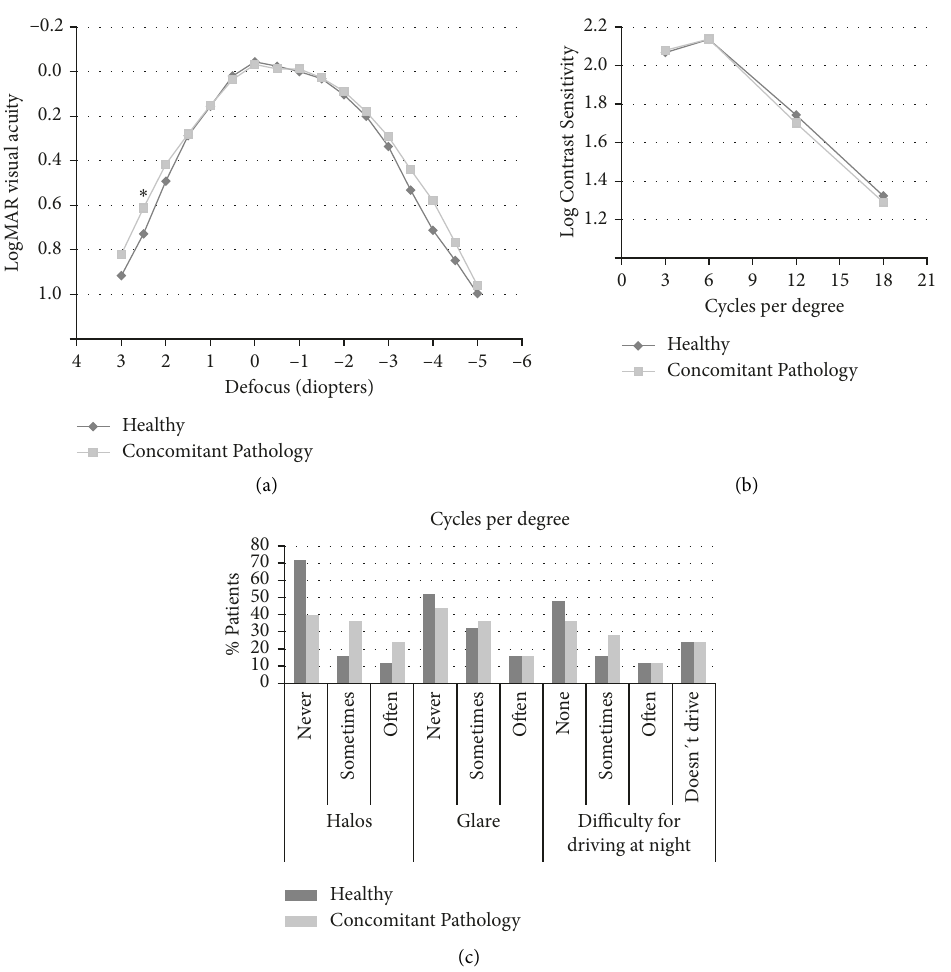
Figure 1: (a) Defocus curves for the study group (concomitant pathology) and the control group (healthy subjects). The asterisk ( the only defocus value, in which there was a statistically significant difference between groups (+2.50 diopters, p sensitivity. There were no statistically significant differences between groups. (c) Prevalence of halos, glare, and difficulty for driving at